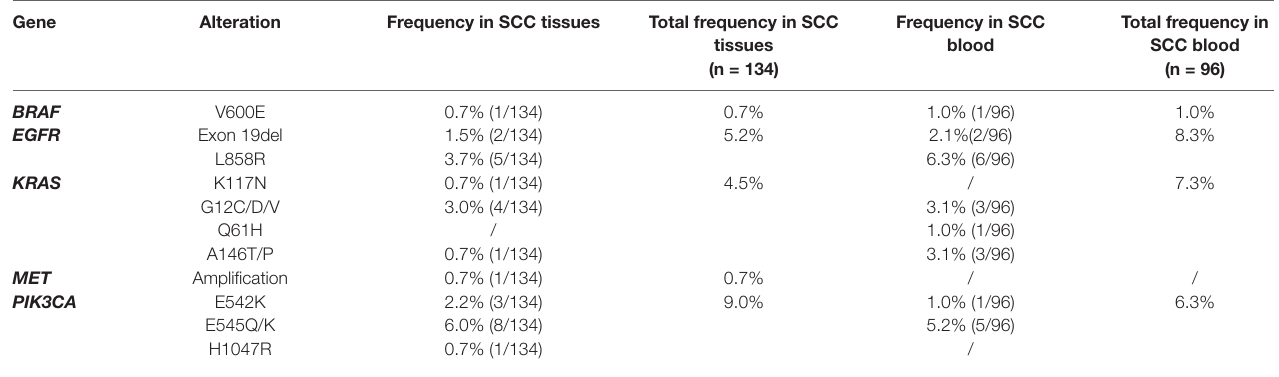
TaBLE 4 | Frequency of mutations in lung squamous cell carcinoma